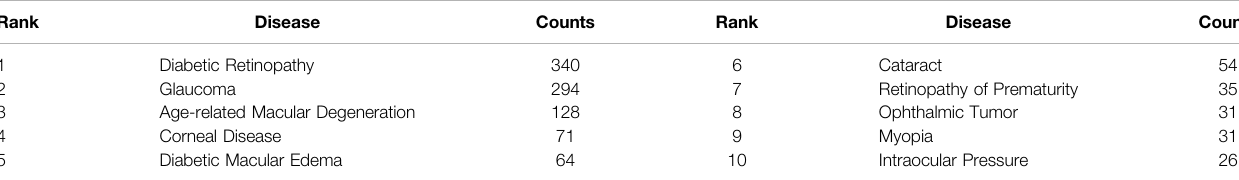
TABLE 6 | Top ten diseases mentioned in the published literature from 2020 to 2021.